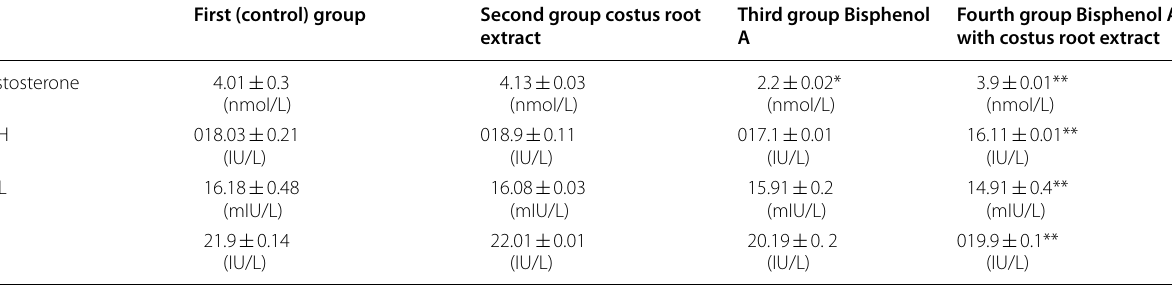
Table 3 Effect of the treatment with Bisphenol A alone or together with costus root extract on levels of testosterone, FSH, PRL, and LH